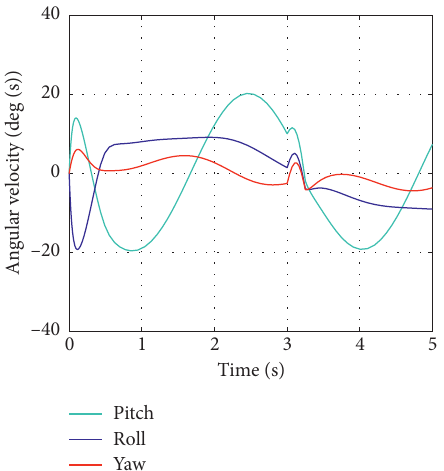
Figure 6: The angular velocity of robot body along three axes.